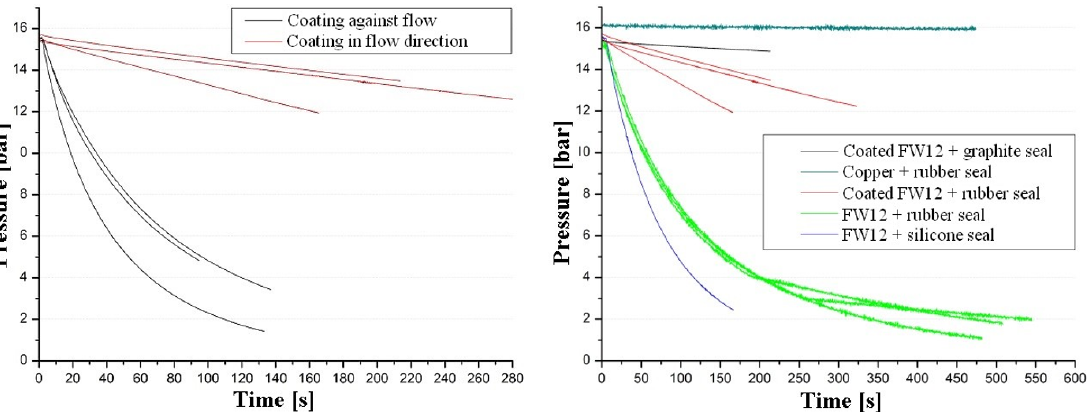
Figure 16. Pressure curves determined in leak tests, ( left ) in relation to the installation direction of the coated specimens and ( right ) comparing different types of